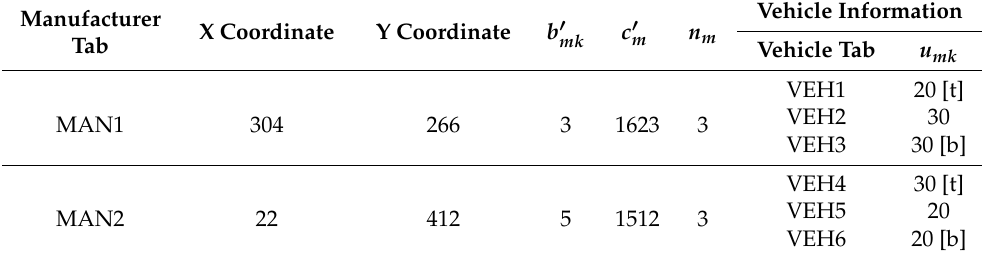
Table 7. Manufacturer information of